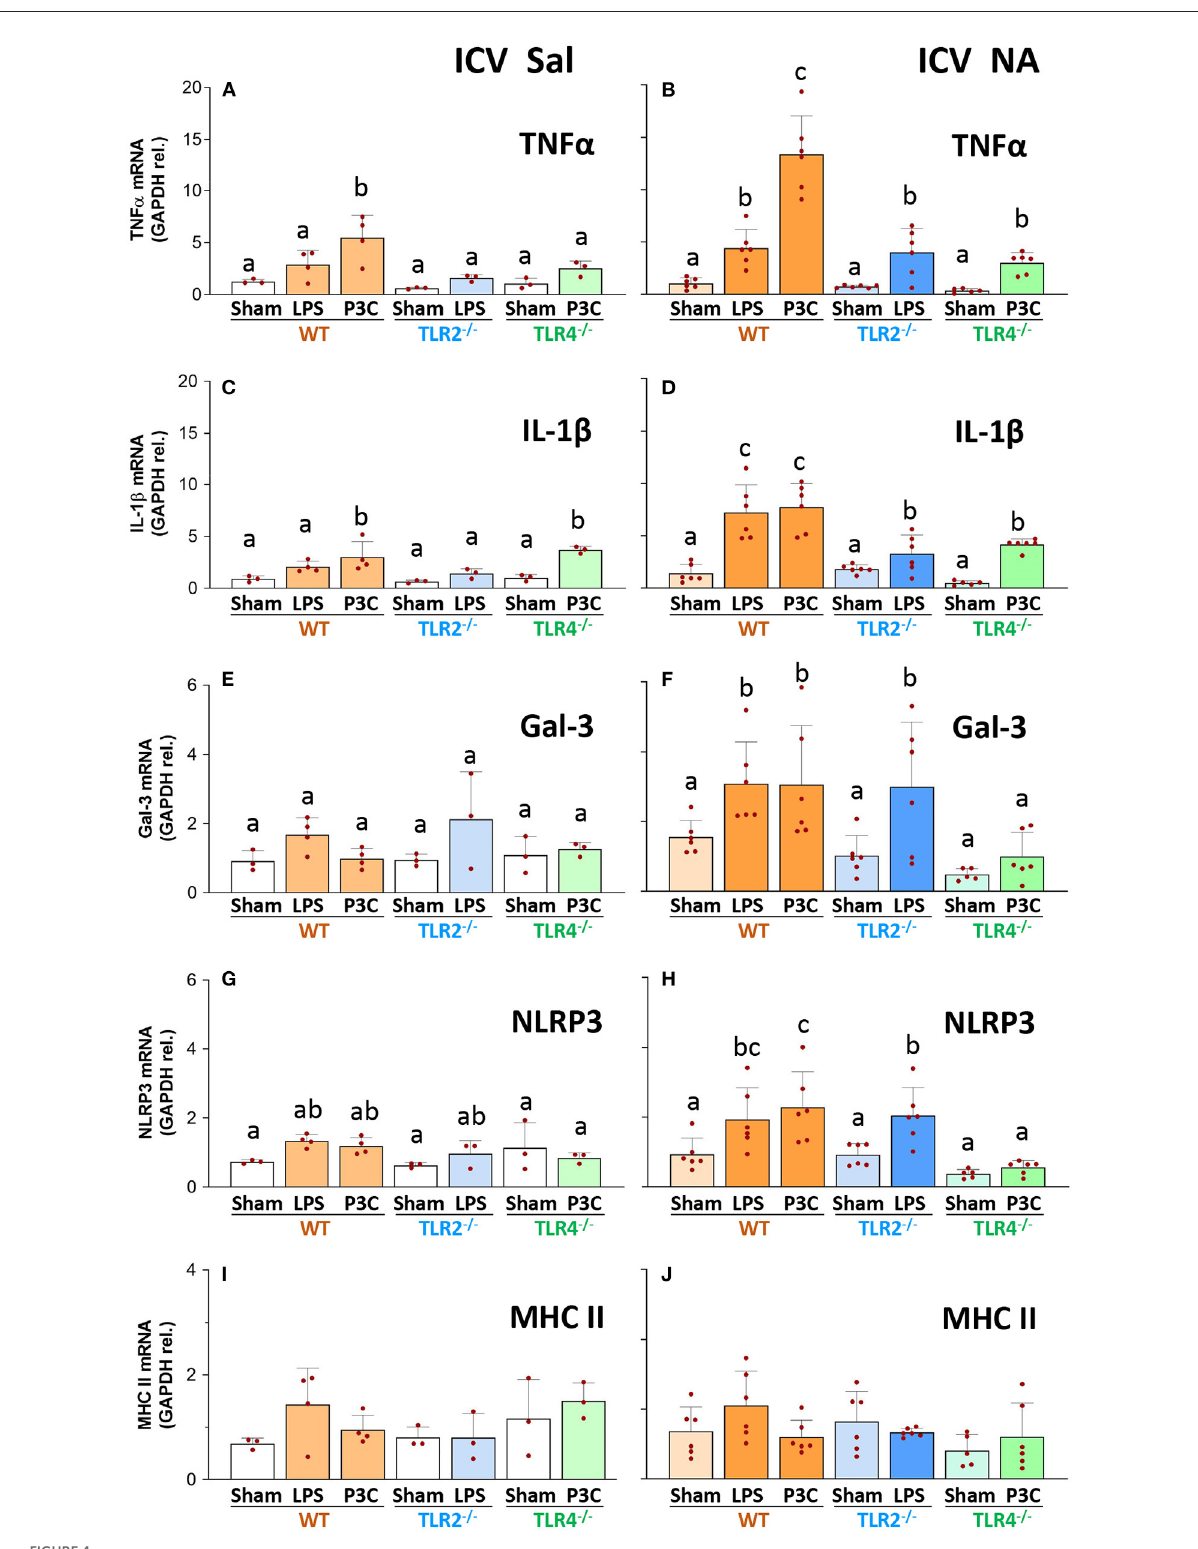
FIGURE4 Gene expression of inflammatory markers in the hypothalamus of WT, TLR2 − / − and TLR4 − / − mice after a double inflammatory stimulus. The mRNA was extracted from the hypothalamus of mice first treated ICV with NA (controls injected with saline), and three months later